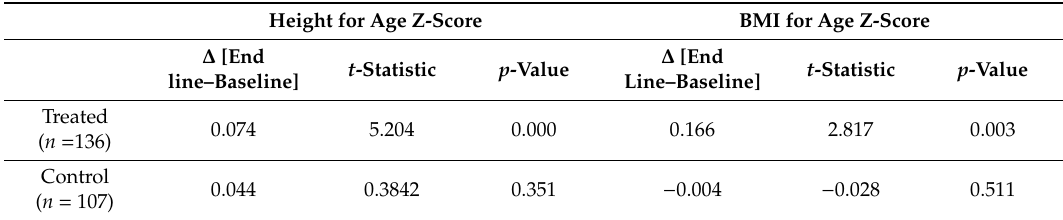
Table 8. Paired t test of the change in mean Z-scores for undernutrition indicators from the baseline to the end line by treatment